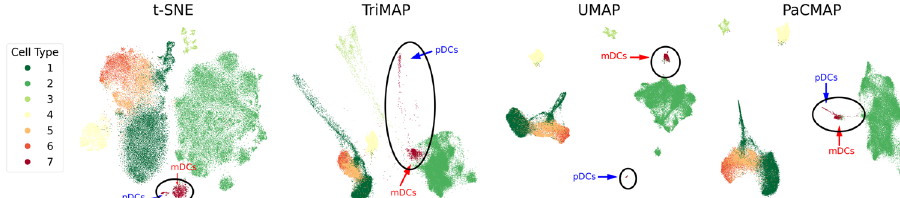
Fig. 1 Comparison of global structure preservation for DR methods. DR visualizations of a scRNAseq dataset of PBMCs from HIV-infected people from ref. 6 , pre-processed using the top 70 principal components. Labels for cell types were identi fi ed by differential expression analysis for each cluster. DC clusters are circled. Note that DR algorithms can behave differently under different random seeds, and we discuss the implication of such behavior in Supplementary Note 3 and Supplementary Fig.